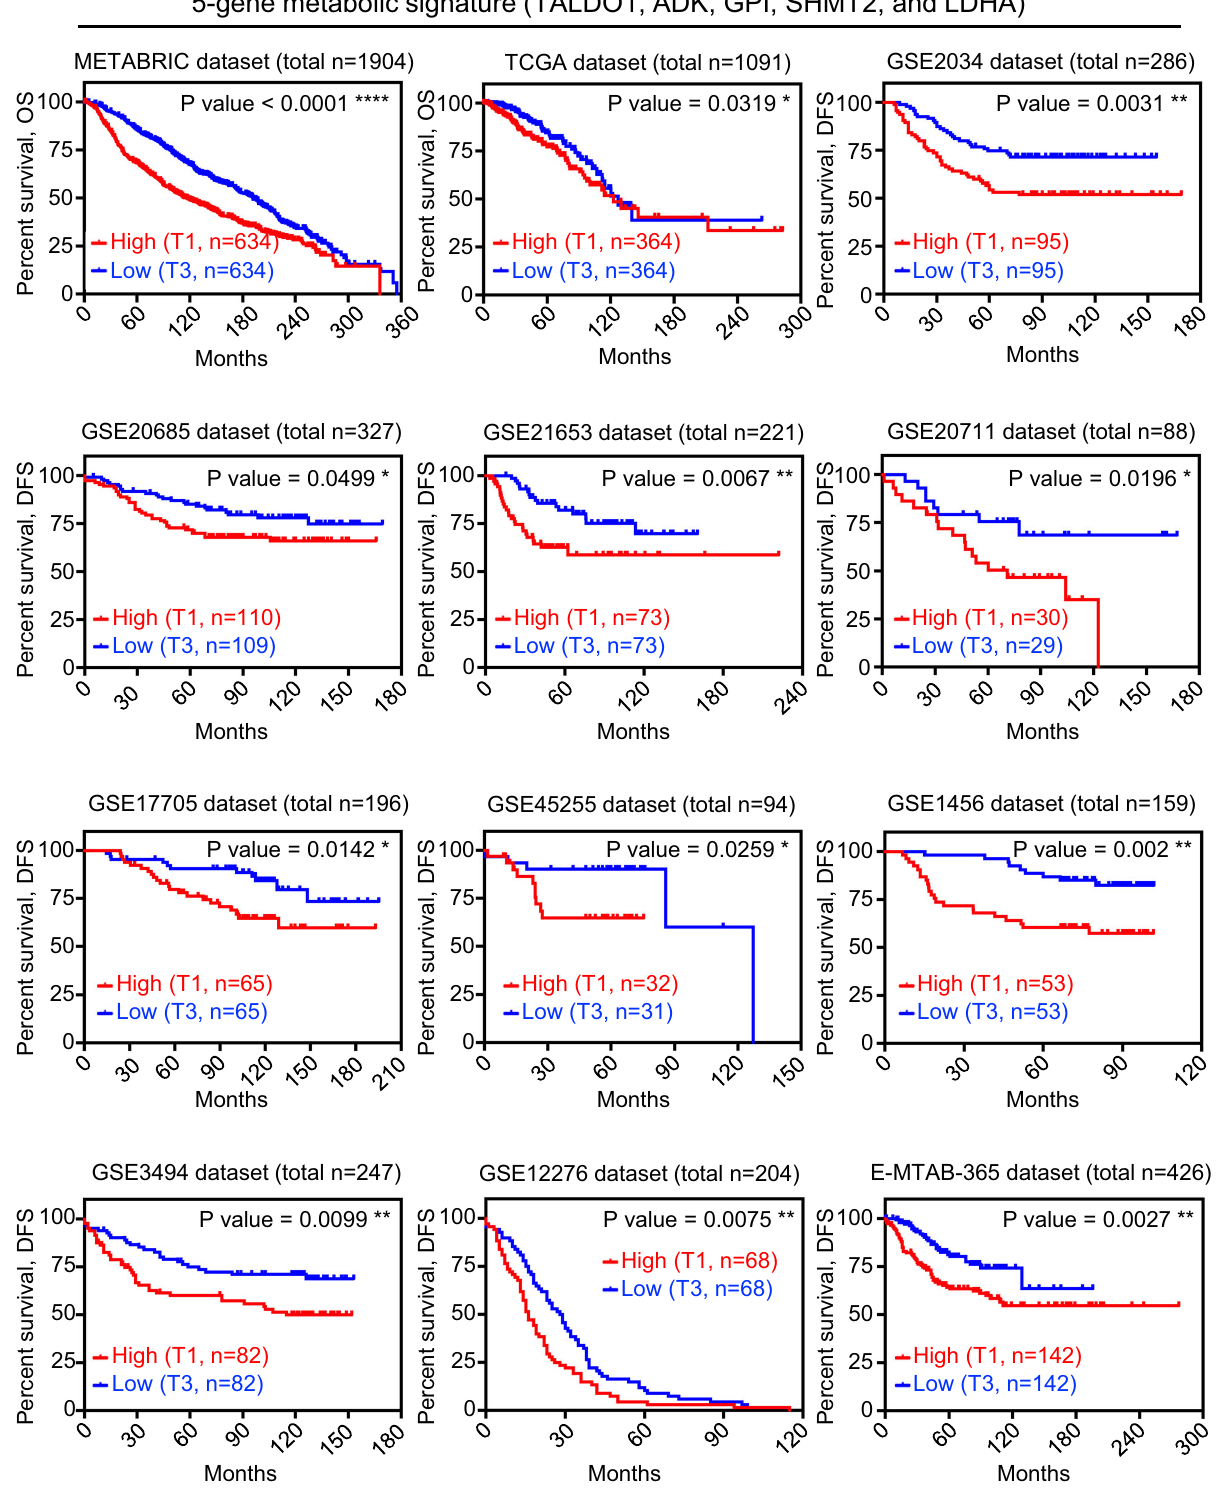
Fig. 6 Five-gene metabolic signature predicts worse overall and disease-free survival in breast cancer patients. Survival curves (overall survival or recurrence-free survival) of breast cancer patients were sorted into two subgroups as upper tertile (T1) and lower tertile (T3) based on the mean of mRNA z -score of 5 metabolic genes per sample from 12 clinical public datasets. The overall survival (OS) information of METABRIC 57 and TCGA (Firehose Legacy) clinical datasets are obtained from cBioPortal for Cancer Genomics 58,59 . The relapse-free survival (RFS) information of all other clinical datasets is generated using Kaplan – Meier Plotter (https://kmplot.com/analysis/index.php?p = service) 62 . P value of survival analysis was calculated based on Log-Rank Test in Prism software. * P <0.05, ** P <0.01, **** P